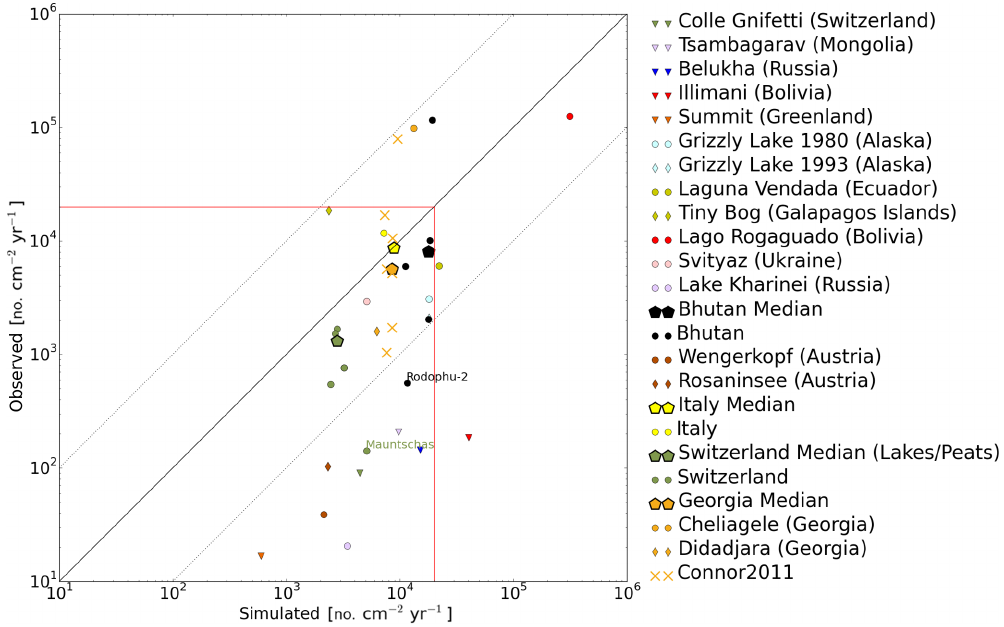
Figure 3. Simulated vs. observed number fluxes of charcoal particles above a threshold radius of r eq = 4 . 9µm (in cm − 2 yr − 1 ) for the validation data set (with an emission number geometric mean radius of r eq = 5µm and a charcoal density of 0 . 6gcm − 3 ). The triangles refer to observations from ice cores; all other data are from sediments. The same colours are used for samples from the same countries. The data from Connor (2011) are distinguished by symbols (X’s) because a different method was used. To improve readability, the different sediment observations from Bhutan, Italy, Switzerland, and Georgia are not further distinguished in the legend since the observation sites in these countries are close together. The median over them is illustrated by the large pentagrams. The red frame shows the axis limits of Fig. 4. The black solid line is the 1 : 1 line; the lines that are 1 order of magnitude away from the 1 : 1 line are dotted.